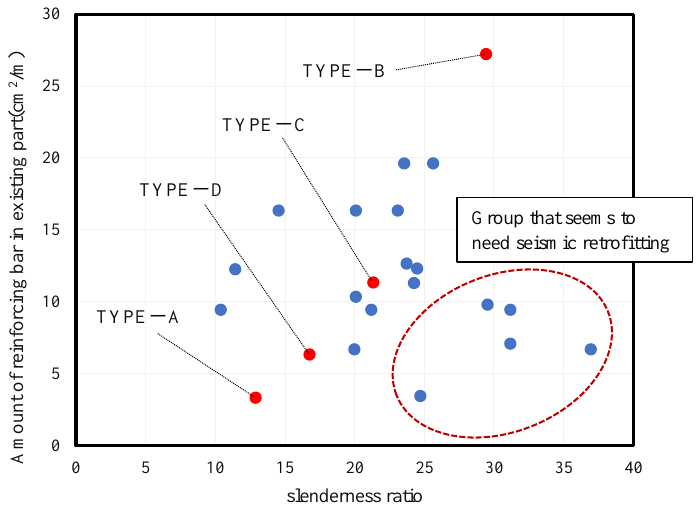
Figure 12. Classification of dams by slenderness ratio and amount of reinforcing bar.